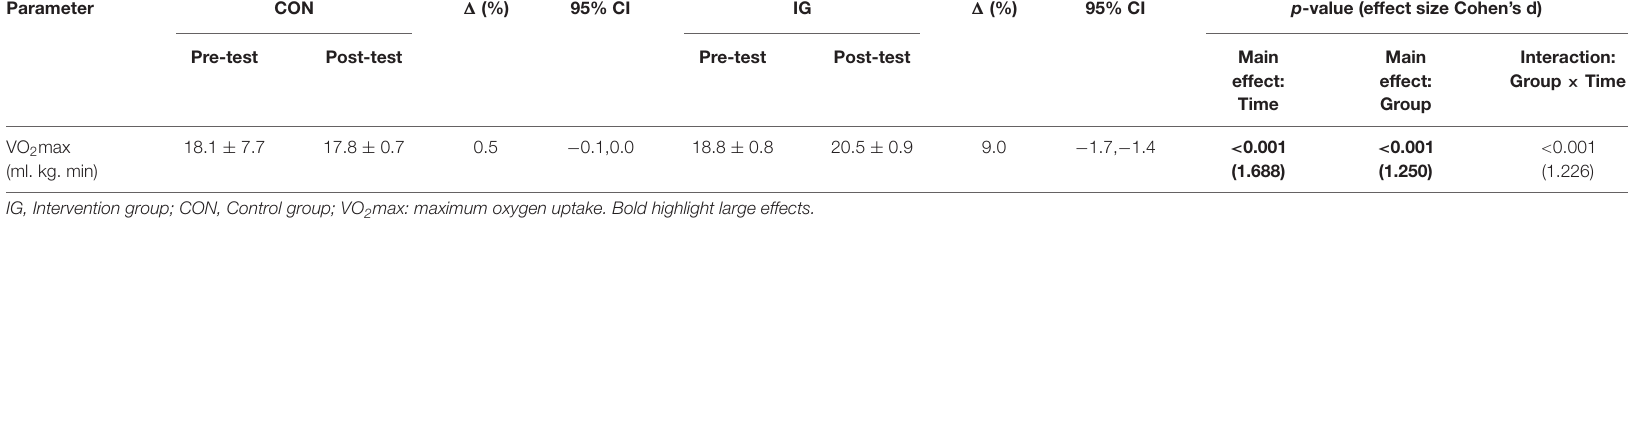
TABLE 5 | Group-specific stance time and kinetic data during walking at constant speed (1 m/s) before and after training. Parameter CON (cid:49) (%) Pre-test Post-test Pre-test Post-test Main effect: